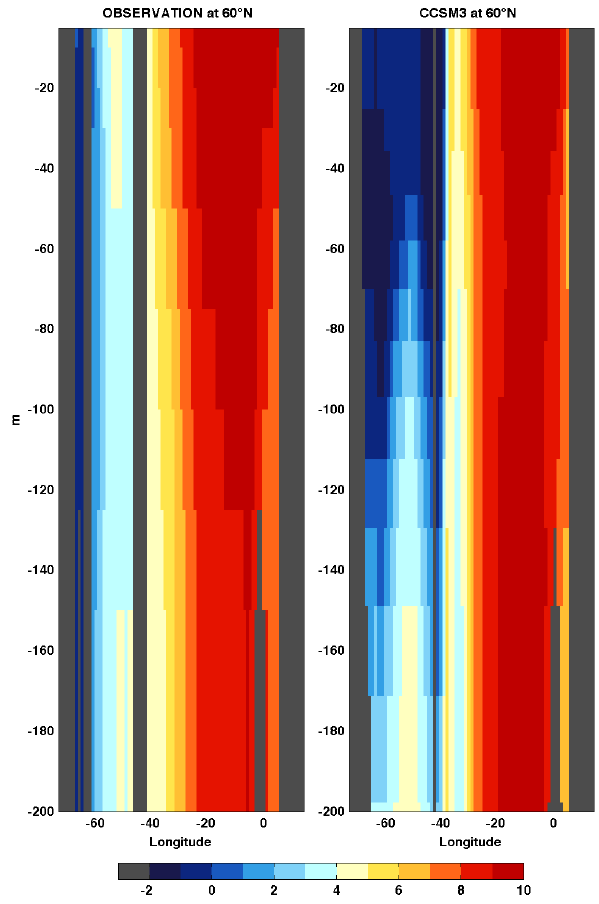
Fig. 2. Comparisons of annual temperature between CCSM3 and WOA98 at a transect 60 ◦ N. NODC WOA98 data were provided by the NOAA/OAR/ESRL PSD, Boulder, Colorado, USA, from their Web site at http://www.esrl.noaa.gov/psd/. a distinct difference between SST estimates derived from phytoplankton based records, i.e. the diatom and alkenone records, and zooplankton based records (foraminifers and ra- diolarians) (Fig. 6). Most phytoplankton species of coccol- iths and diatoms thrive in the upper photic zone correspond-